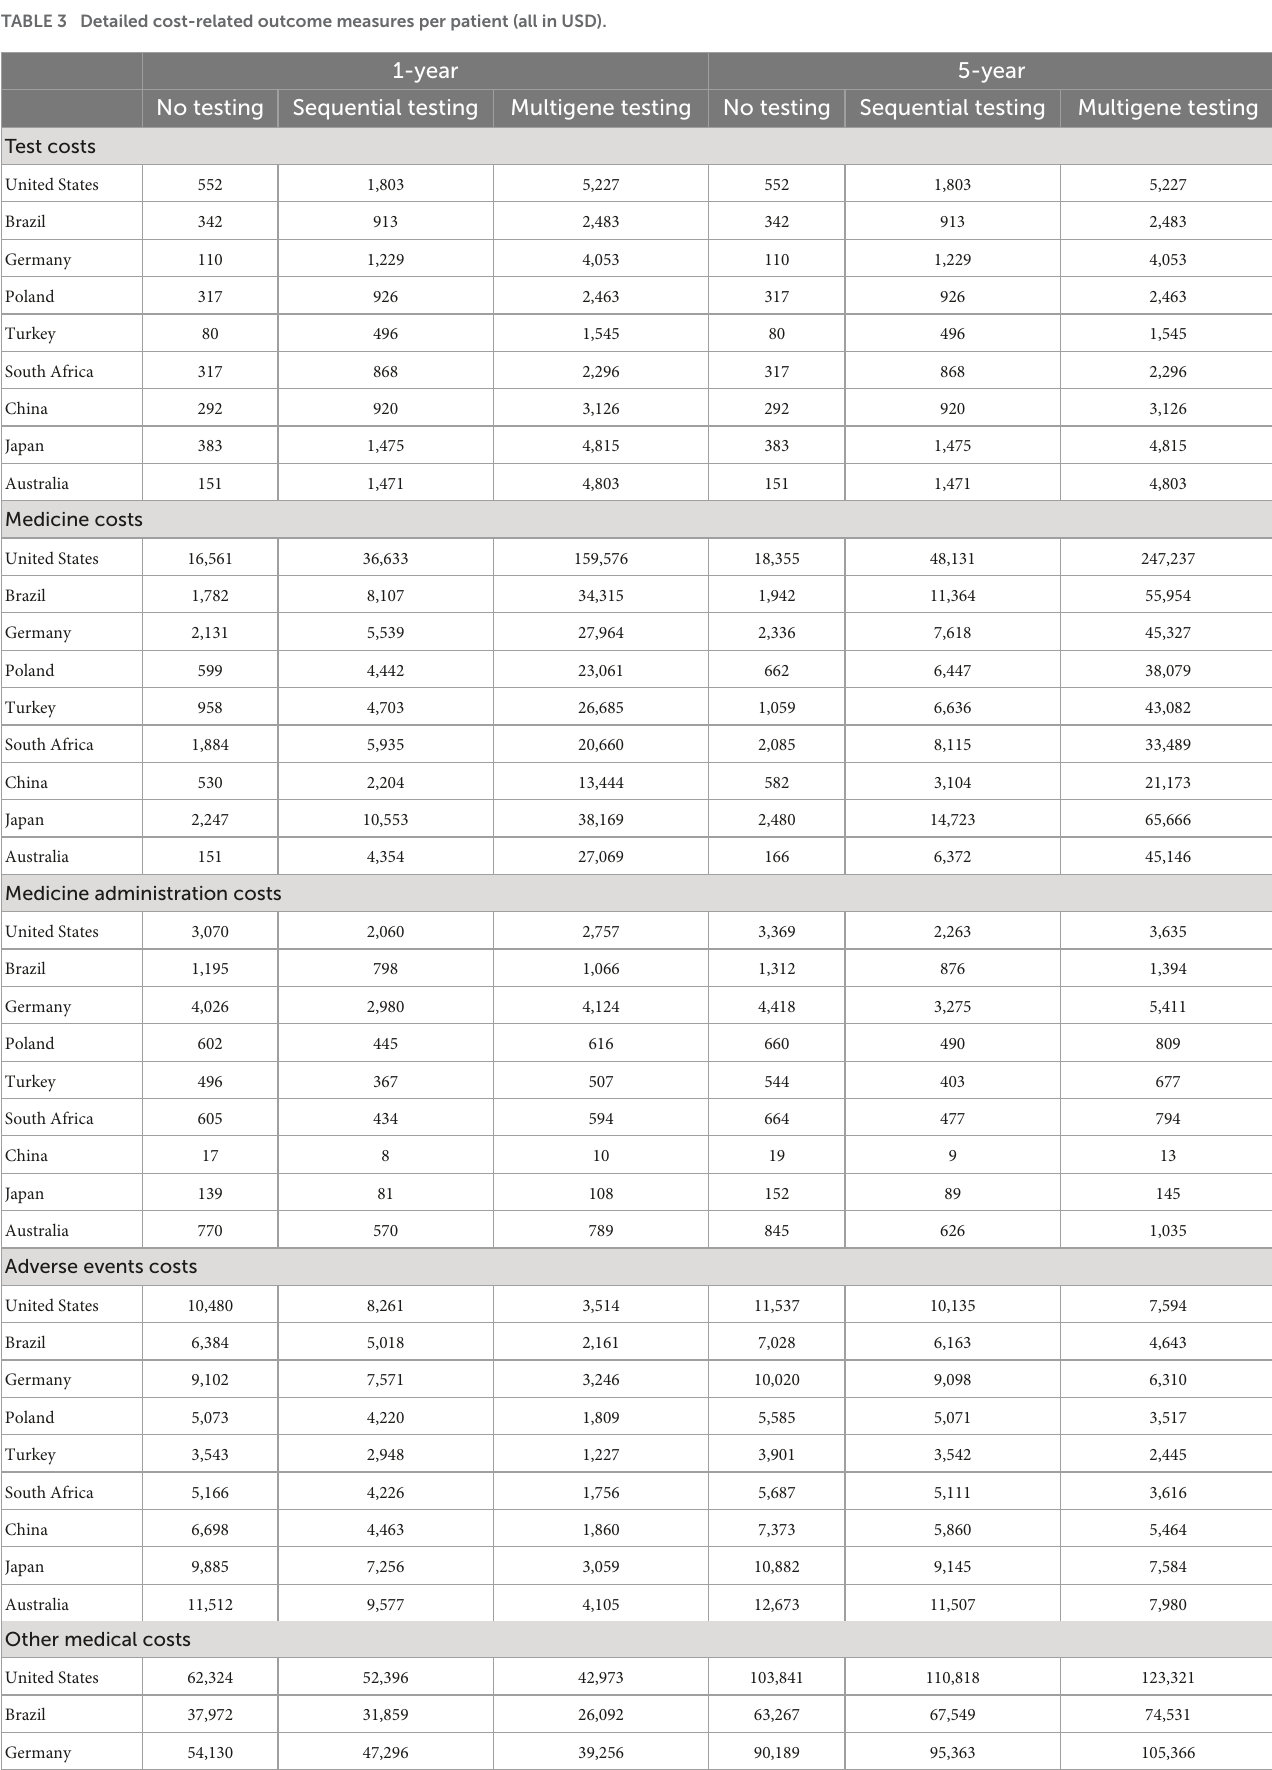
TABLE 3 Detailed cost-related outcome measures per patient (all in